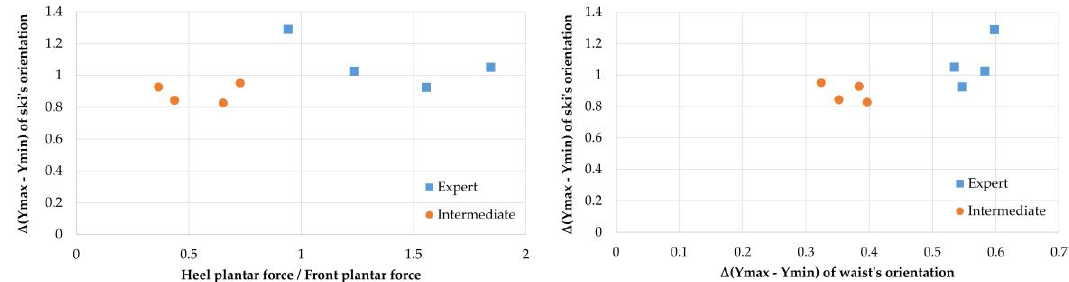
Figure 9. Relationship between two ski-turn features and orientation change of ski (calculated as the difference between the maximum and minimum values of the orientation). The ( left pane ) shows the load ratio between the front and heel side of the plantar force as the feature of ski loading (defined as the heel plantar force divided by the front plantar force). The ( right pane ) shows the amount of the waist’s orientation change in the direction of travel as the feature of body